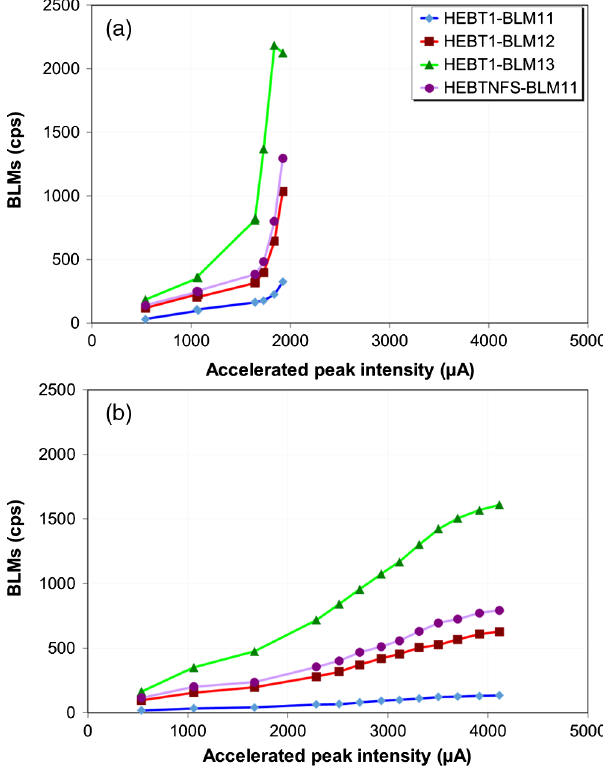
FIG. 12. Losses in the HEBT lines a function of the beam peak intensity: (a) with insufficient gain feedback for the cavity fields and (b) for an optimized LLRF